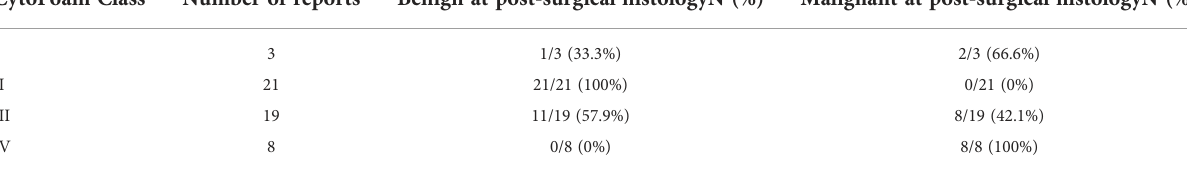
TABLE 2 CytoFoam Core System reports vs. post-surgical histology. CytoFoam